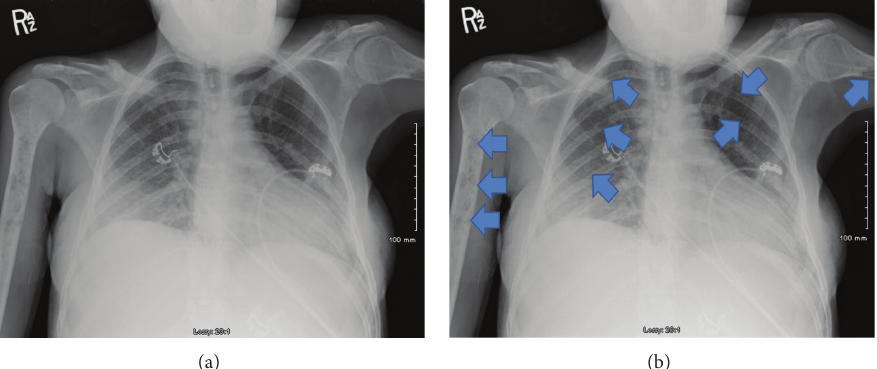
Figure 1: Chest radiograph of patient showing diffuse lytic bone lesions (indicated by blue arrows), most prominent in bilateral humeri and healed fracture deformities in the clavicles and ribs.